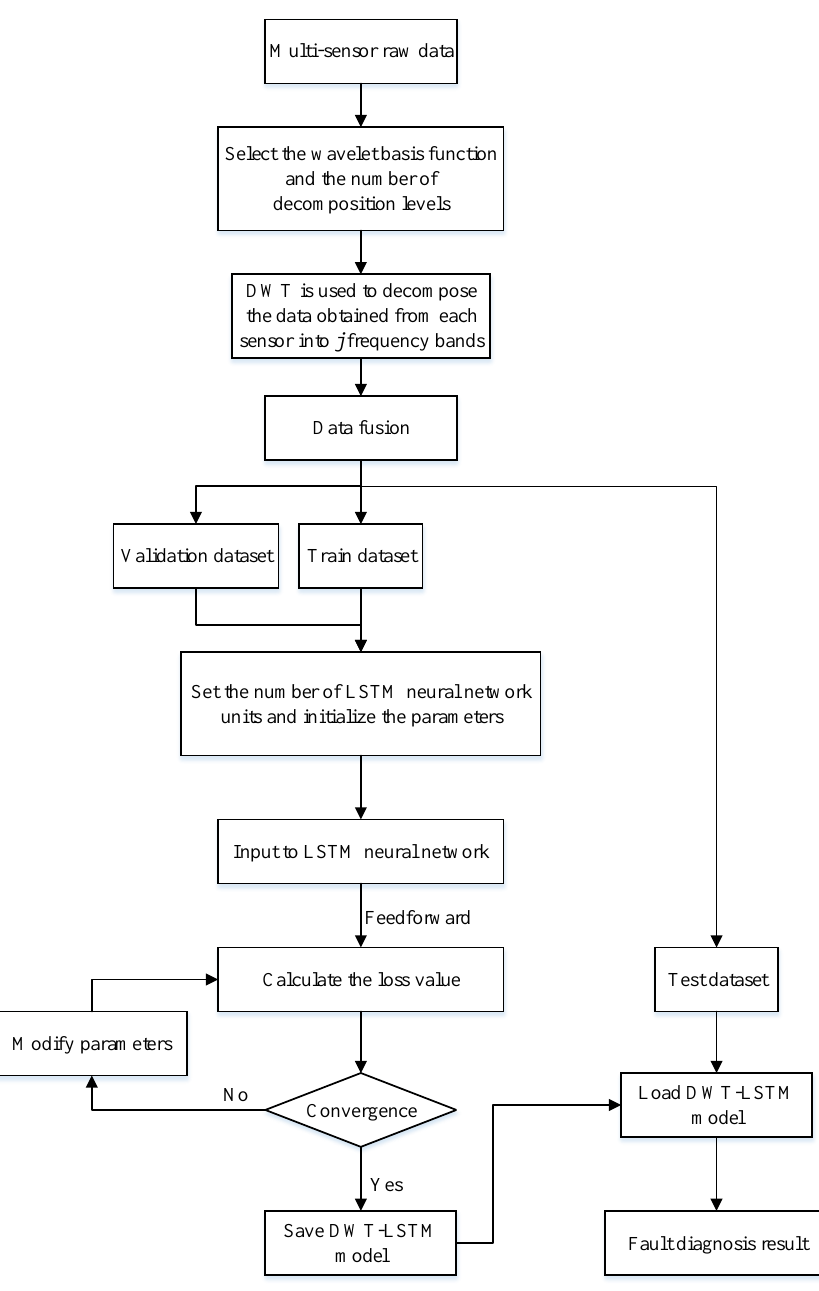
Figure 4. Flow chart of the proposed diagnosis